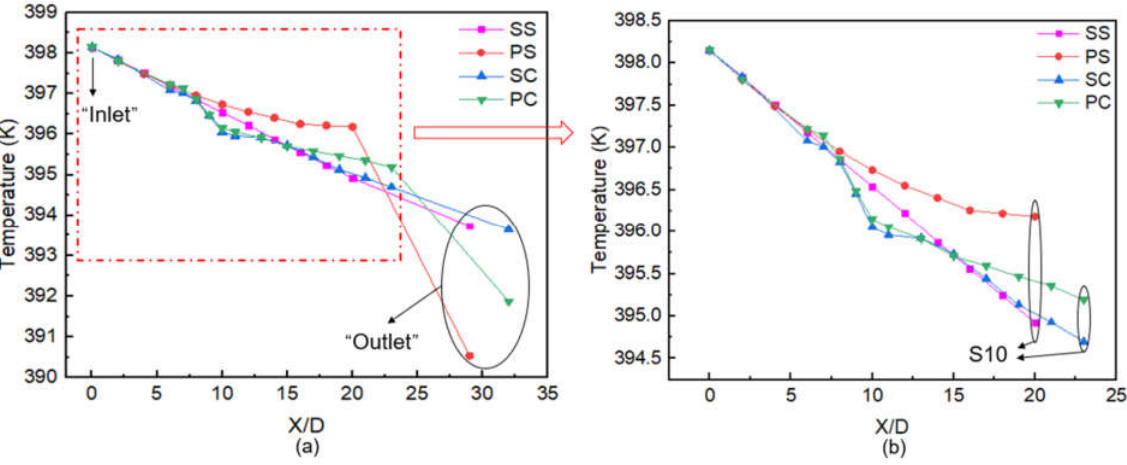
Figure 14. Average temperatures in the streamwise direction of the “SS”, “PS”, “SC”, and “PC”: ( a ) all measurement sections, ( b ) from “Inlet” to S10.